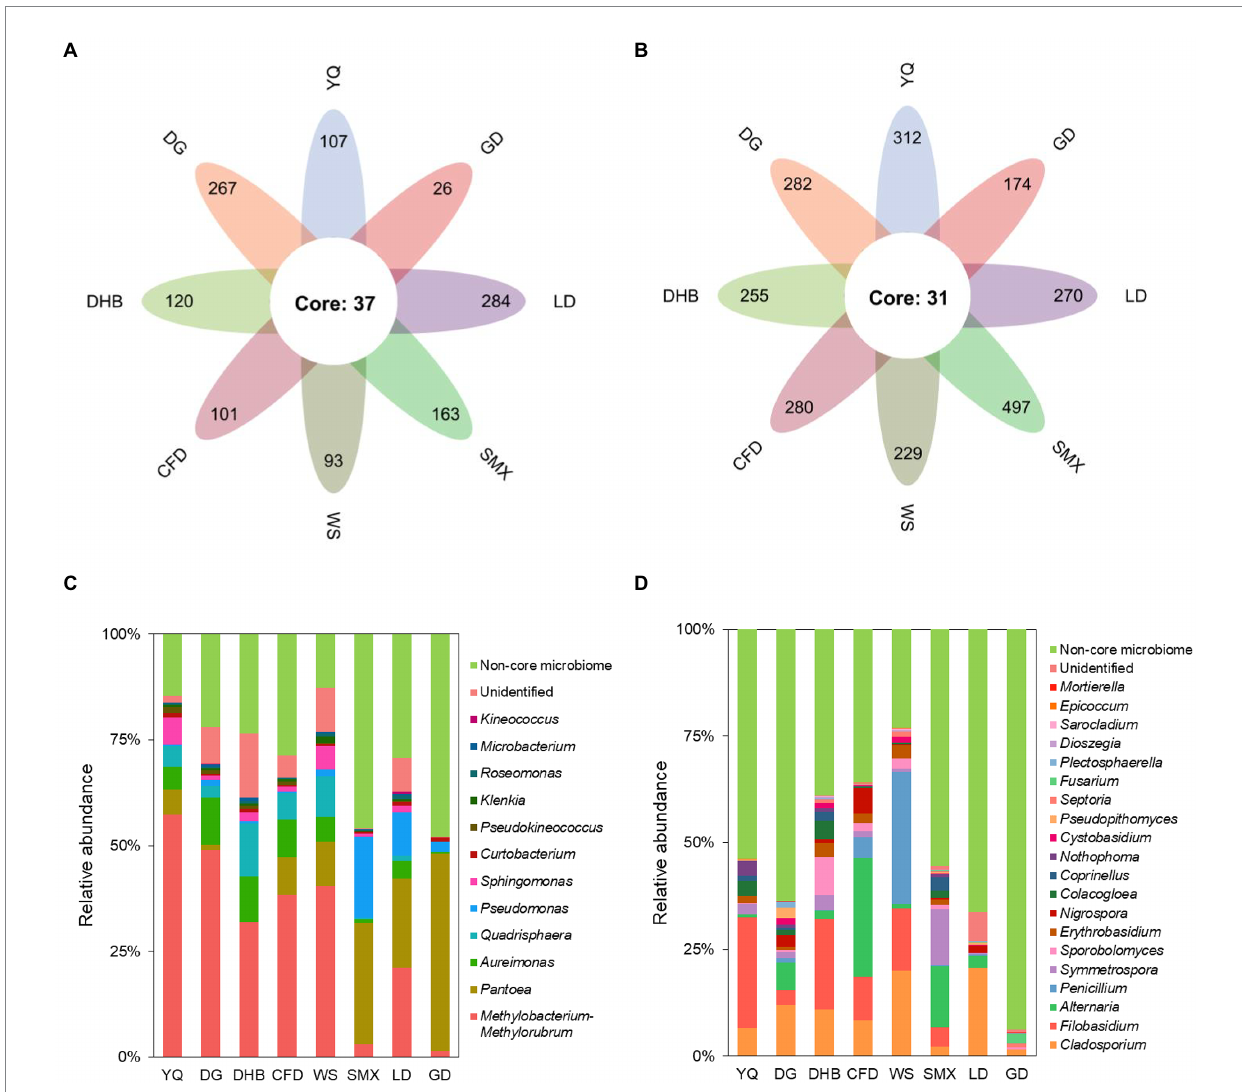
FIGURE 5 The core microbes of eight genotypes of bacterial (A) and fungal (B) communities. The relative abundance at the genus level of the core bacterial (C) and fungal (D) taxa in the foliar microbiome of wild soybean. The non-core taxa are indicated in